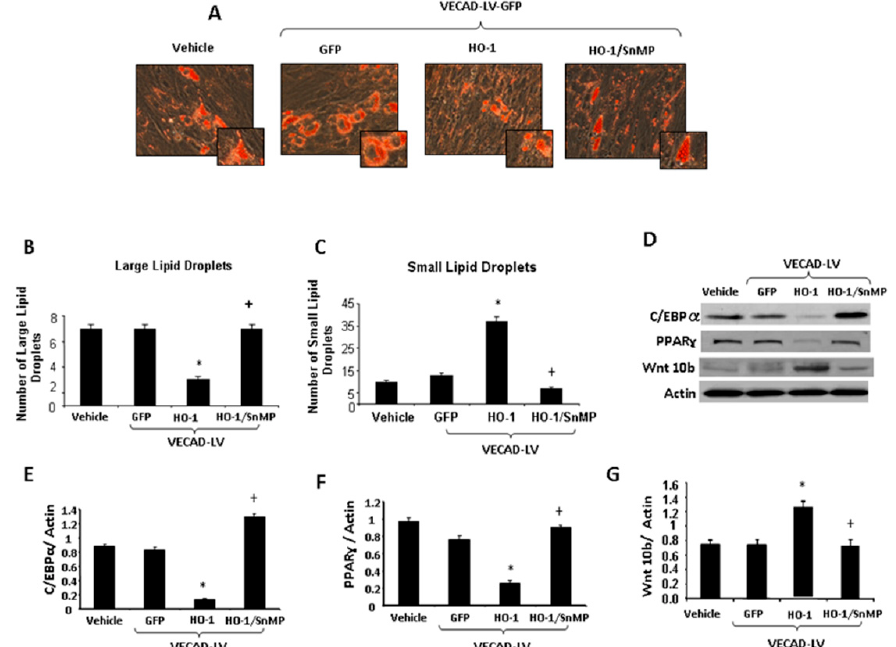
Figure 5. ( A ) Adipogenesis in MSC-derived adipocytes following administration of CM from EC treated with VECAD-GFP, VECAD-HO-1, and VECAD-HO-1 + SnMP. ( B , C ) Lipid droplet size of